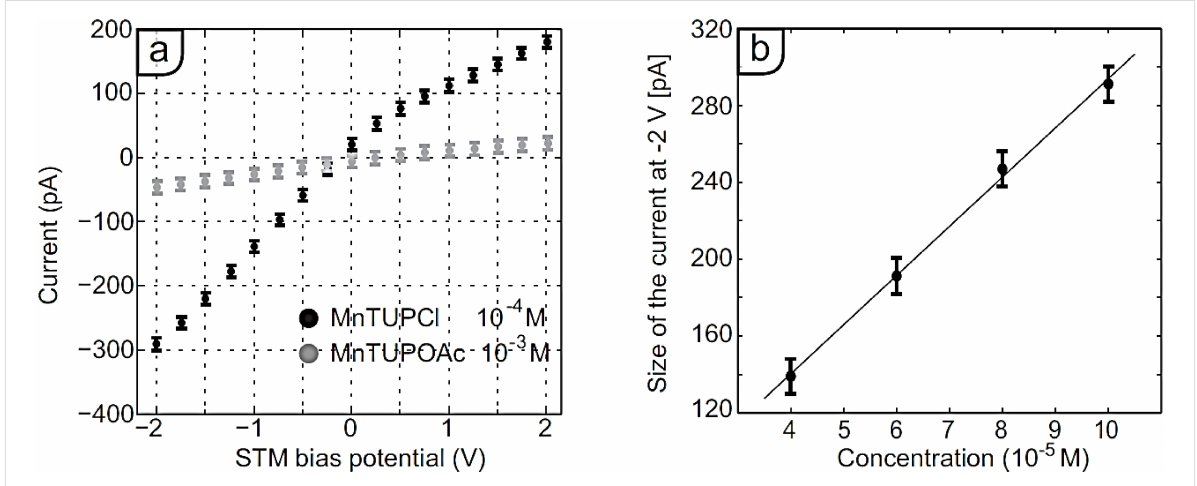
Figure 2: (a) Bias voltage dependence of the measured current in the STM setup at the interface of HOPG and a solution in 1-phenyloctane of MnTUPCl ( c = 1 × 10 − 4 M, black) and of MnTUPOAc ( c = 1 × 10 − 3 M, grey). (b) Concentration dependence of the measured current in the STM setup at a bias voltage of − 2 V of MnTUPCl at the same interface ( c = 1 × 10 − 4 M); the line is a linear fit through the data points. Both graphs show the aver- age ±1 S.D. of 1000 measurements recorded within a time span of 1.5